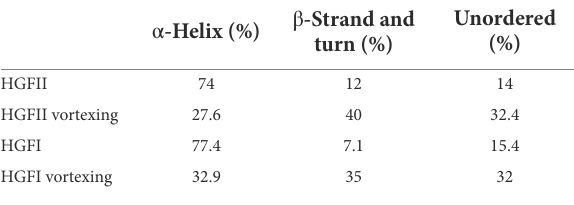
TABLE 2 The contents of secondary structures of HGFII and HGFI.